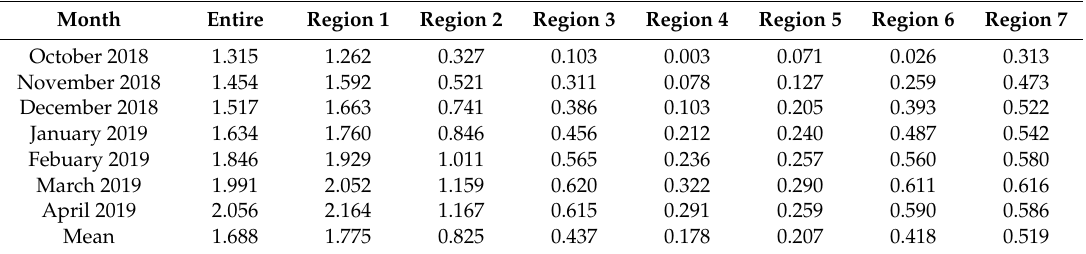
Figure 4. Arctic sea ice density with the LSA method for the 2018–2019 Arctic sea ice growth season from October to April. Table 2. Mean ice thickness (m) of the entire Arctic Basin and seven regions for the 2018–2019 Arctic sea ice growth